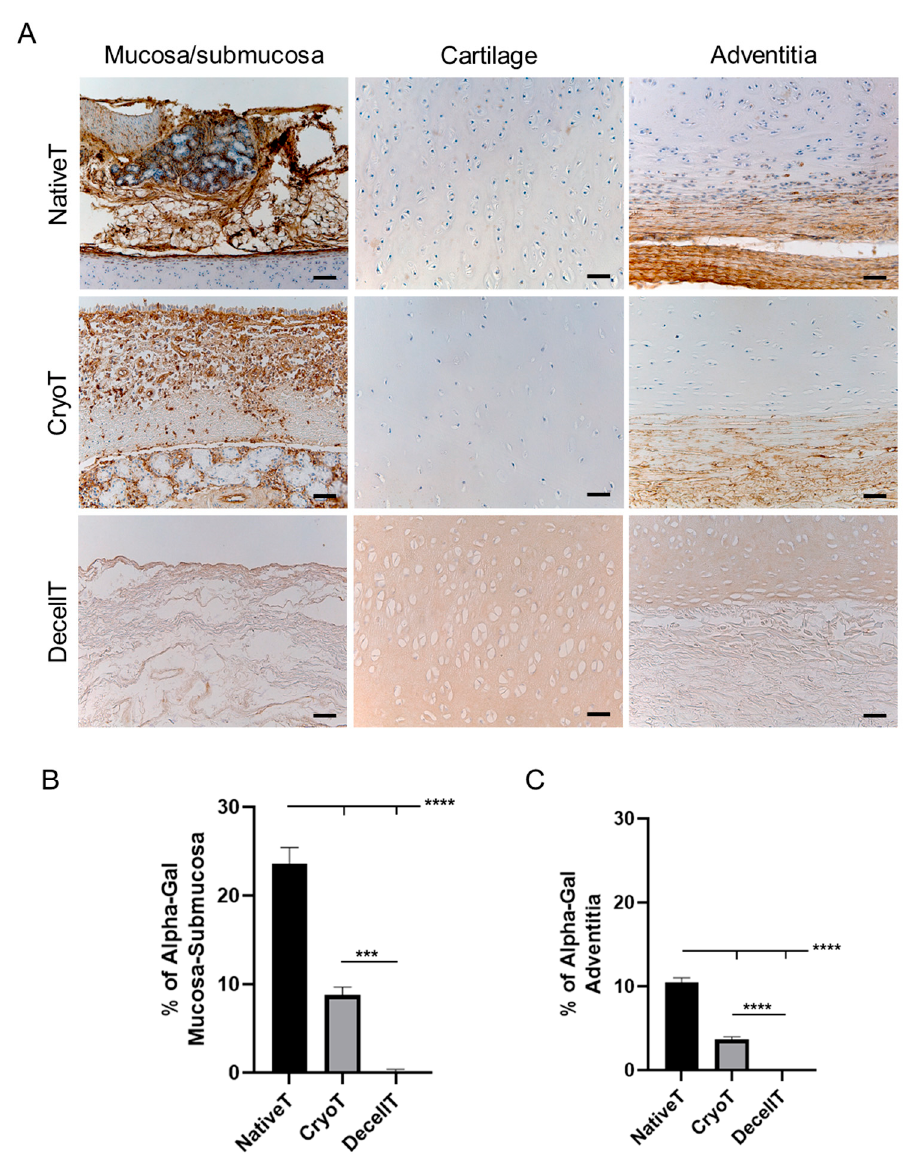
Figure 3. ( A ) Immunolocalization of Alpha-Gal epitopes in cryopreserved (CryoT) and decellularized (DecellT) samples versus native trachea (NativeT) (control). The mucosa/submucosa, cartilage and adventitia were considered separately. Positive elements are stained in brown. Scale bars: 50 µ